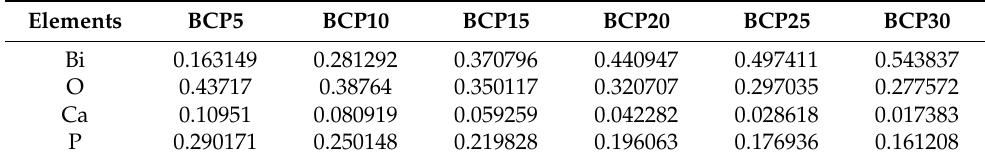
Table 1. Elemental glass composition in fractional weight.